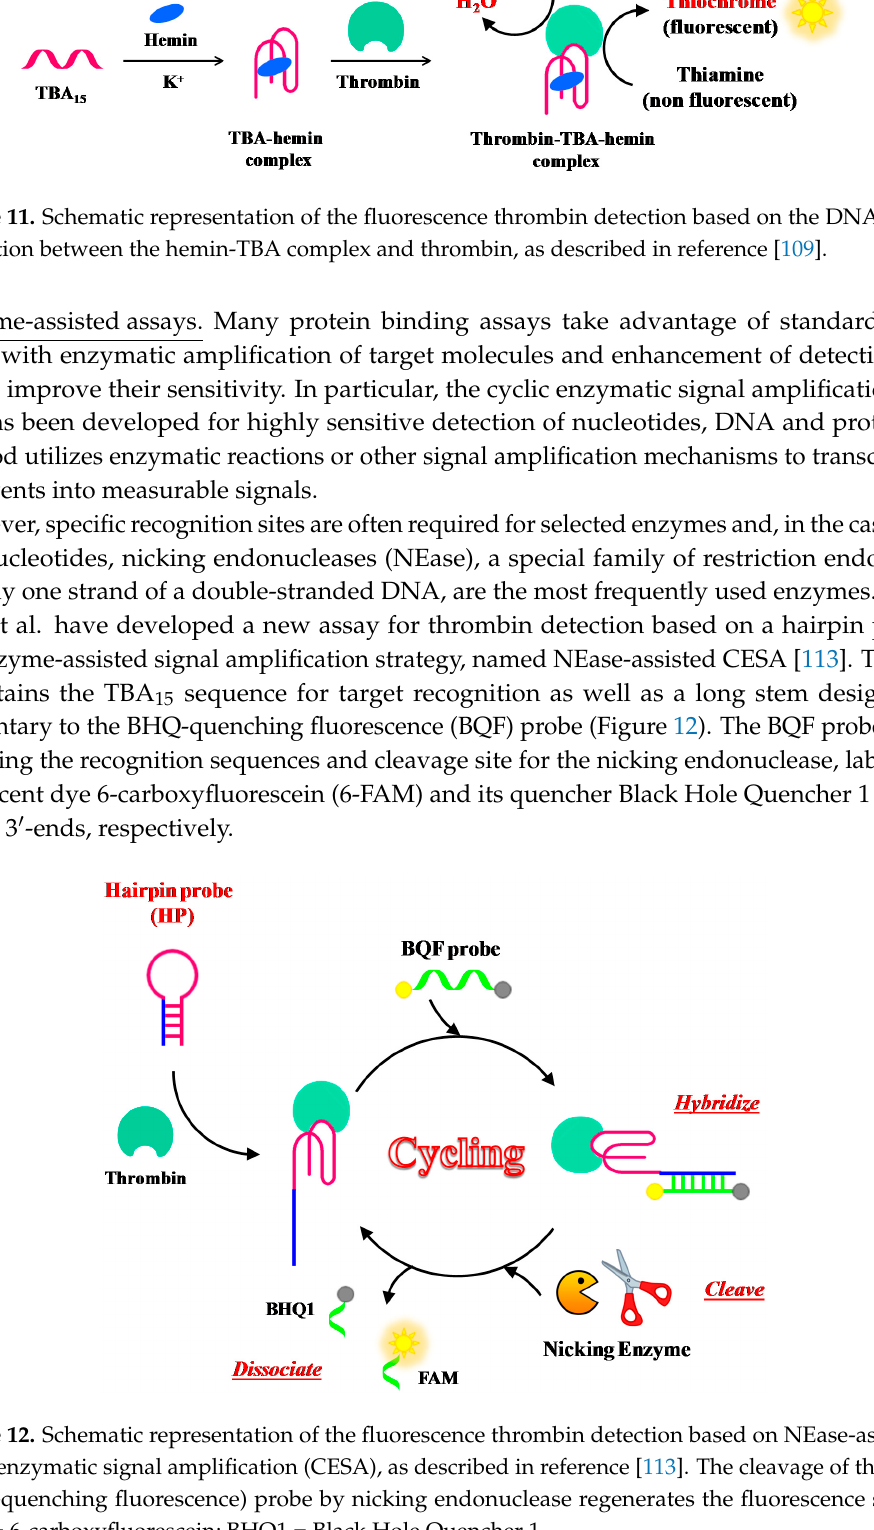
Figure 11. Schematic representation of the fluorescence thrombin detection based on the DNAzyme formation between the hemin-TBA complex and thrombin, as described in reference [109].